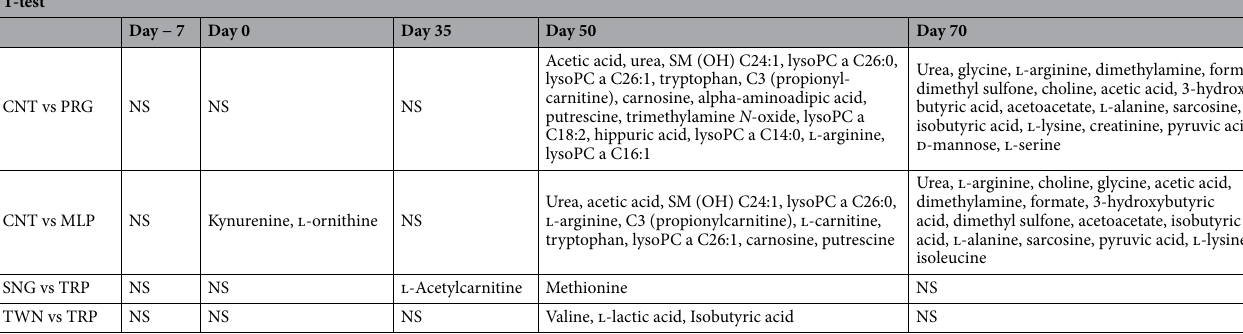
Table 2. Student’s t-test of four comparison groups from the discovery dataset. Statistical analysis using t-test revealed significant (p-value < 0.05) serum metabolites of each comparison at five timepoints during the